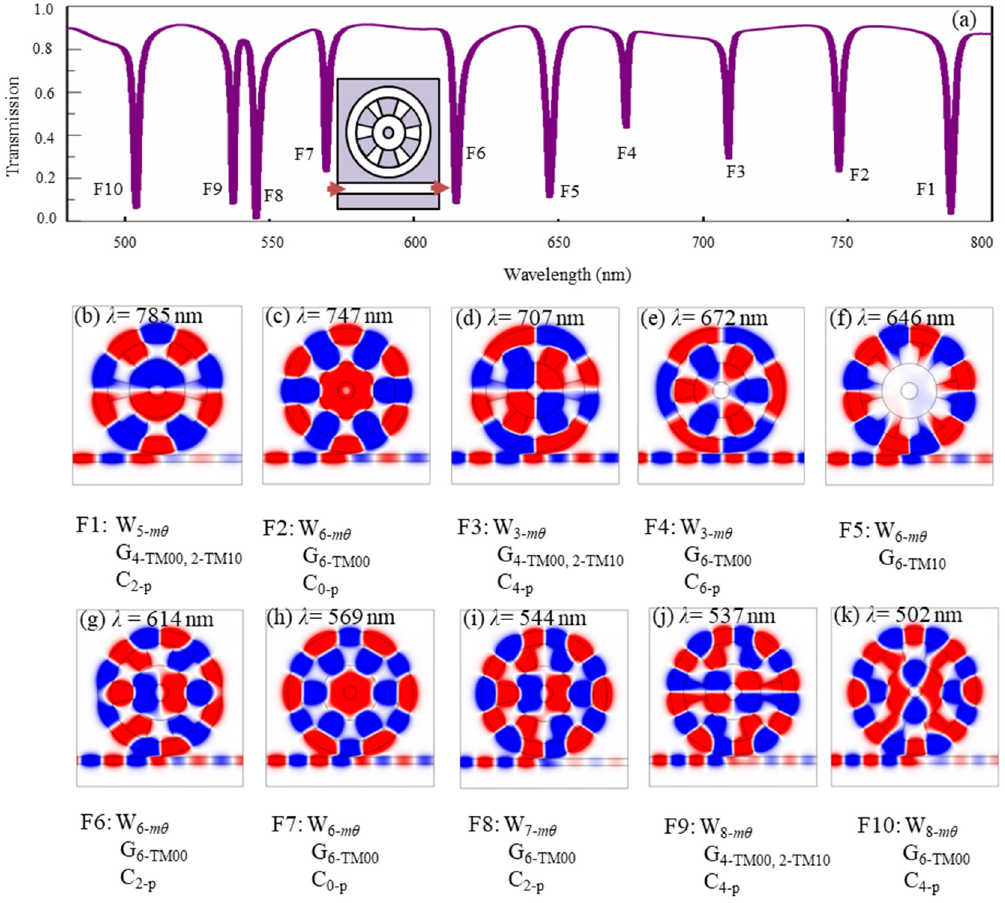
Figure 2. ( a ) The transmission of the fan-shaped structure with D dev = 0, and the H z -field distributions at the transmission dips of ( b ) F1 with λ = 785 nm, ( c ) F2 with λ = 747 nm, ( d ) F3 with λ = 707 nm, ( e ) F4 with λ = 672 nm, ( f ) F5 with λ = 646 nm, ( g ) F6 with λ = 614 nm, ( h ) F7 with λ = 569 nm, ( i ) F8 with λ = 544 nm, ( j ) F9 with λ = 537 nm, ( k ) F10 with λ = 502 nm.